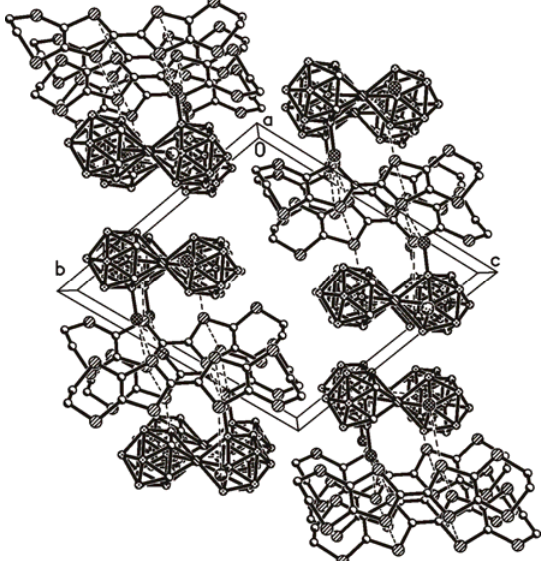
Figure 6. A fragment of crystal structure of (BEDT-TTF)[8,8'-Br B H ) ] ( 2 ). C 2 9 10 2